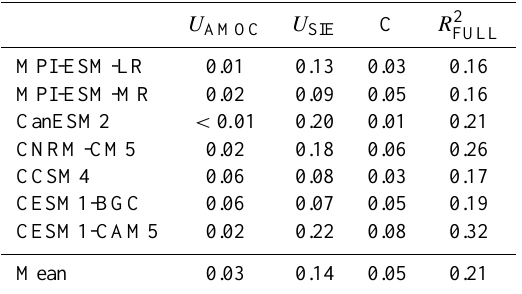
Table 3. Results of the commonality analysis of GMT variability and the AMOC and SIE contribution at lag zero. U AMOC and U SIE denote the unique AMOC and SIE contribution and C the common component. R 2 gives the explained GMT variance by the cou- FULL pled